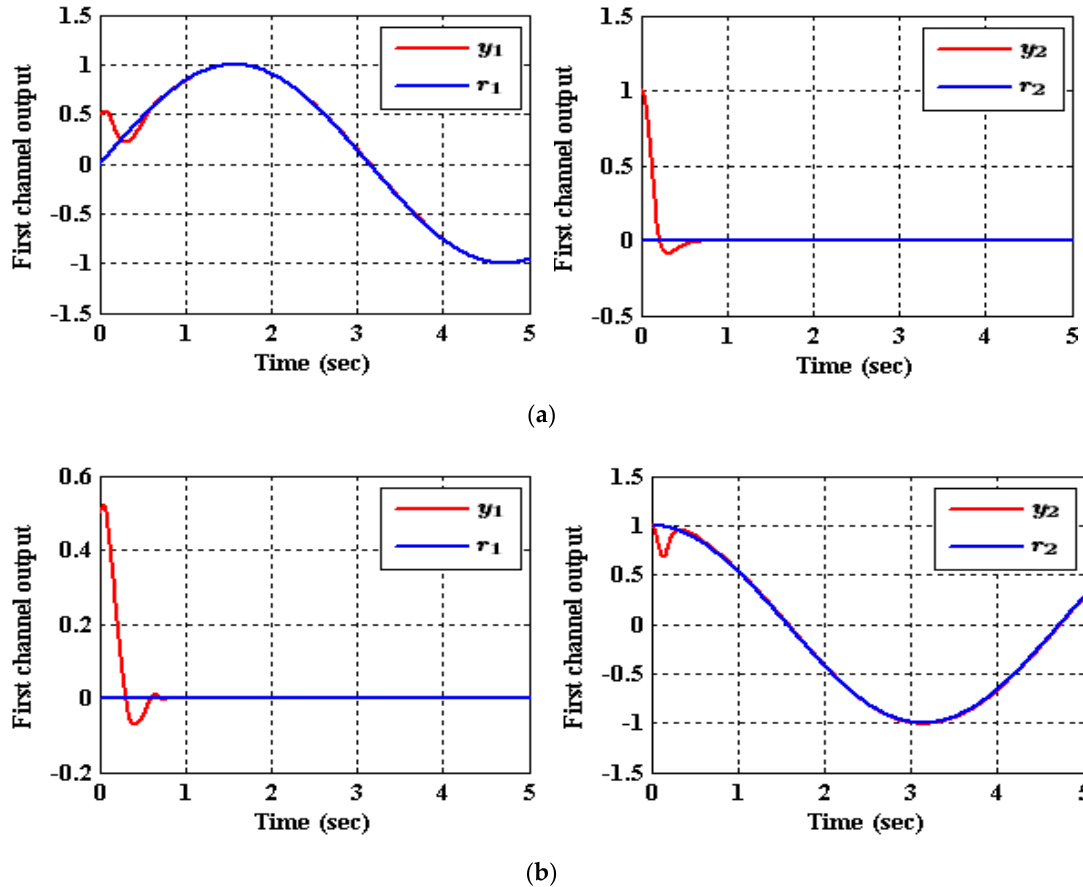
Figure 8. The output tracking of Equation (42) due to reference inputs 𝒓 𝟏 and 𝒓 𝟐 using a decoupled control scheme with CADRC, ( a ) (𝒓 𝟏 , 𝒓 𝟐 ) = (𝐬𝐢𝐧(𝒕) ,𝟎) ; ( b ) (𝒓 𝟏 ,𝒓 𝟐 ) = (𝟎, 𝐜𝐨𝐬(𝒕)) [23] .